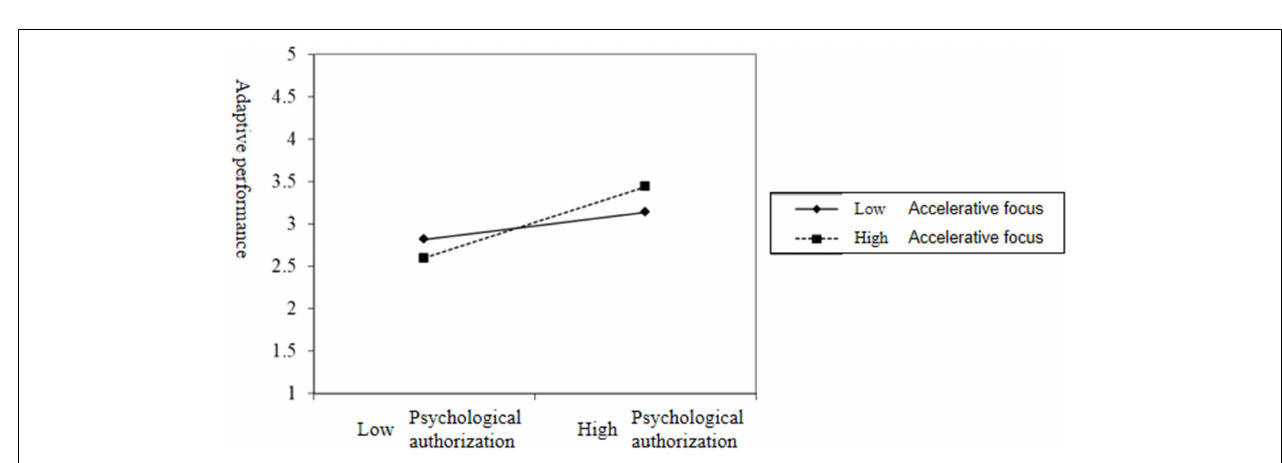
FIGURE 3 | The moderating effect of facilitative moderating focus on psychological empowerment and adaptive performance.